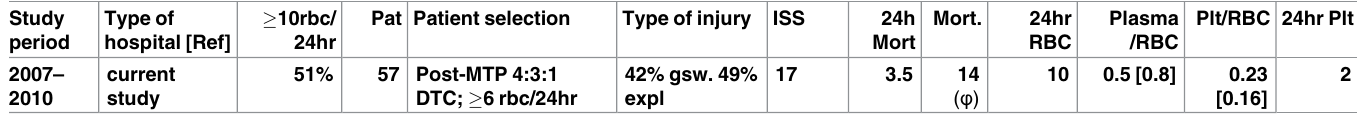
Table is grouped by availabledata (average or median) % of patients receiving (cid:21) 10 RBC/24hr and type of patient selection. Groups are sorted by mortality rate. Calculations : Plasma = FFP = DFP | [ plasma ] = (DFP + Plasma of DTC) ratio | Plt = 1 * aphPLT = 1.5 * bcPLT = 6 * PRP = 2 * FWB = 1 * DTC | [ Plt